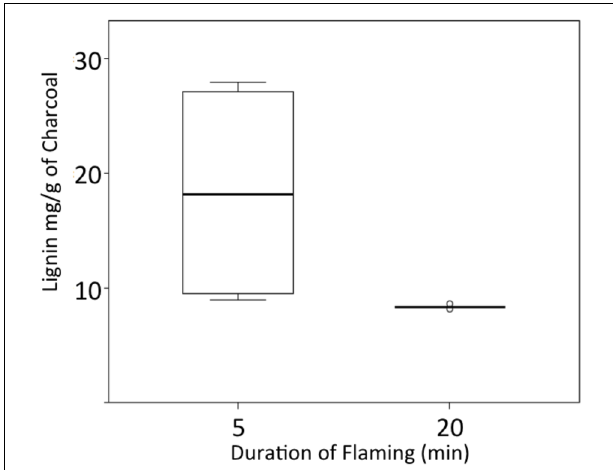
FIGURE 9 | Amount of lignin remaining in chars formed over two different flame durations ( n = 6 per box).